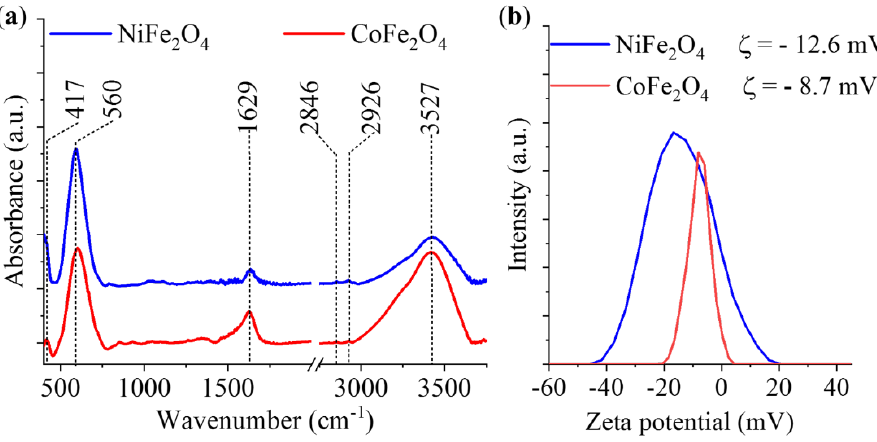
Figure 5. FT − IR spectrum ( a ) and the Zeta potential distribution ( b ) of the NiFe 2 O 4 and CoFe 2 O 4 . Zeta potential measurements were carried out in the case of the two ferrites (673 K) − 8.7 mV (CoFe 2 O 4 ); the negative surface charge can be attributed to the deprotonation of